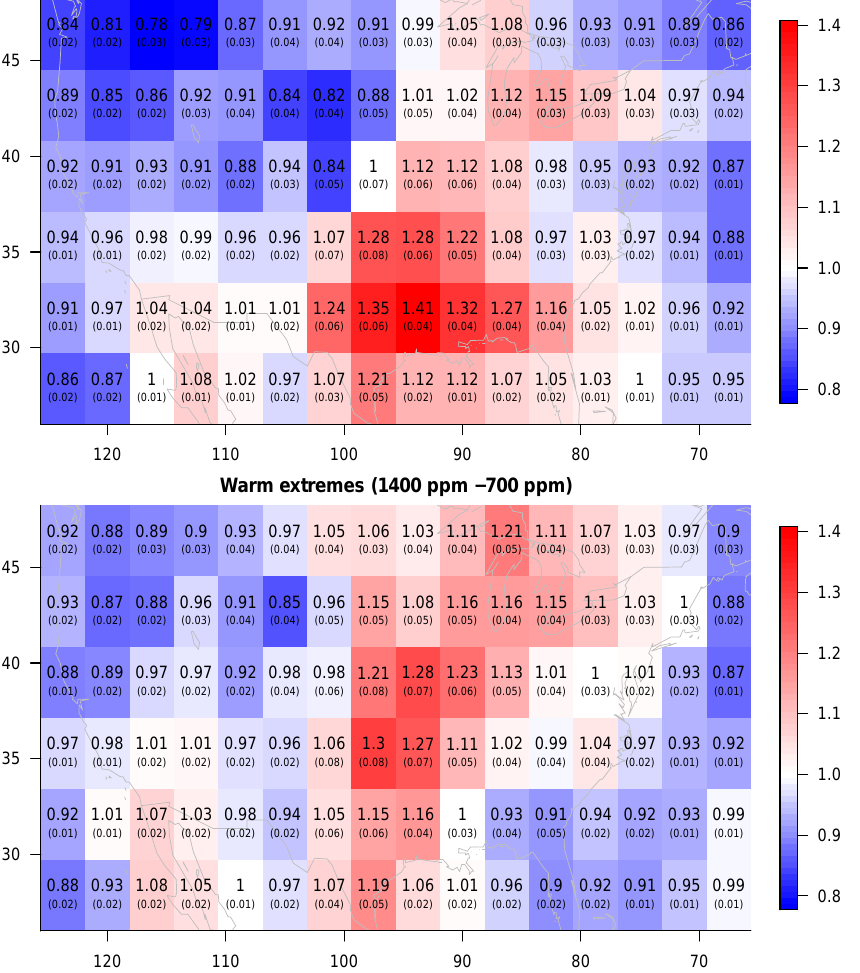
www.adv-stat-clim-meteorol-oceanogr.net/2/79/2016/ Adv. Stat. Clim. Meteorol. Oceanogr., 2, 79–103,